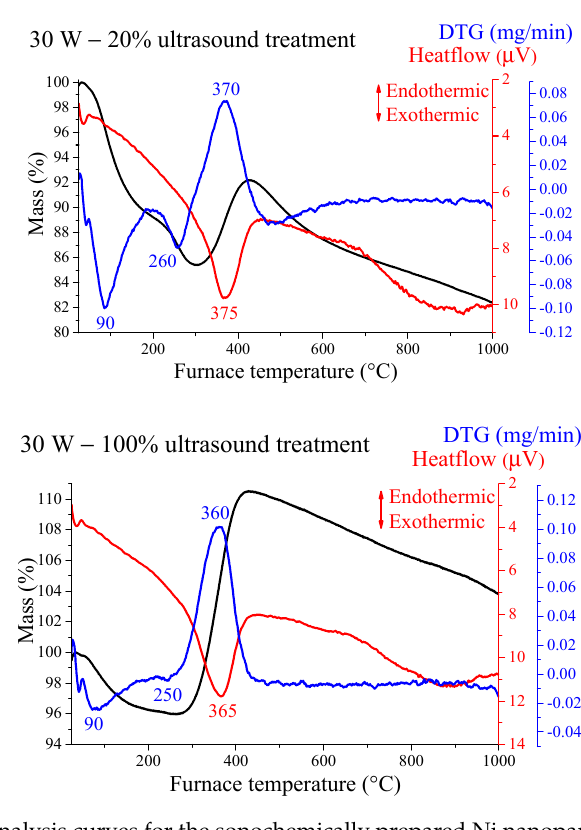
Figure 4. Thermal analysis curves for the sonochemically prepared Ni nanoparticles (NPs) treated at different operating parameters.